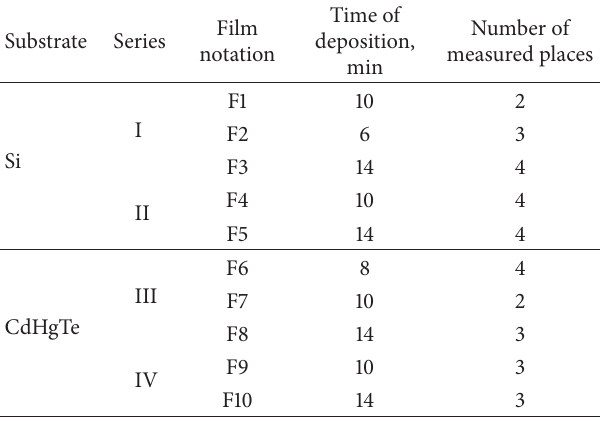
Table 1: Specification of the